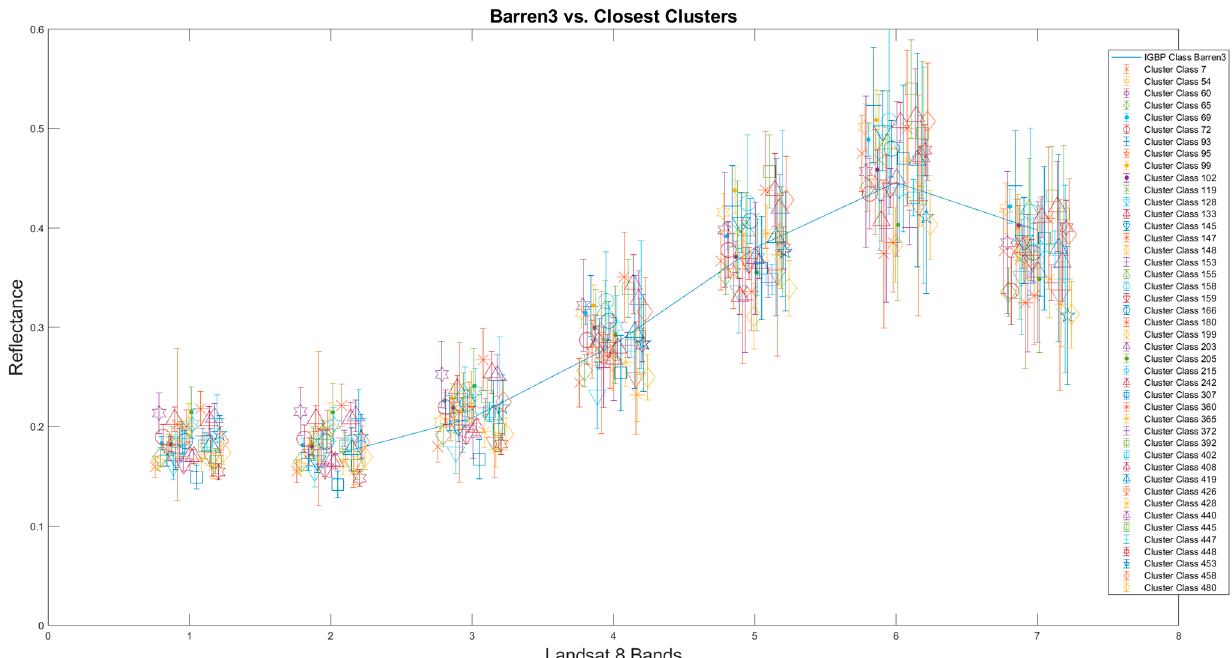
Figure 3. Barren3 reflectance profile plotted against matching clusters. Note the clusters grouping around the banded IGBP profile. The CA band does not have an IGBP value since MODIS does not have a CA band equivalent.